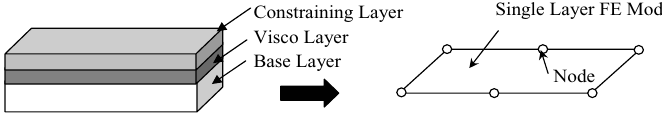
Fig. 1. The single-layer plate element used to represent a three layer structure.